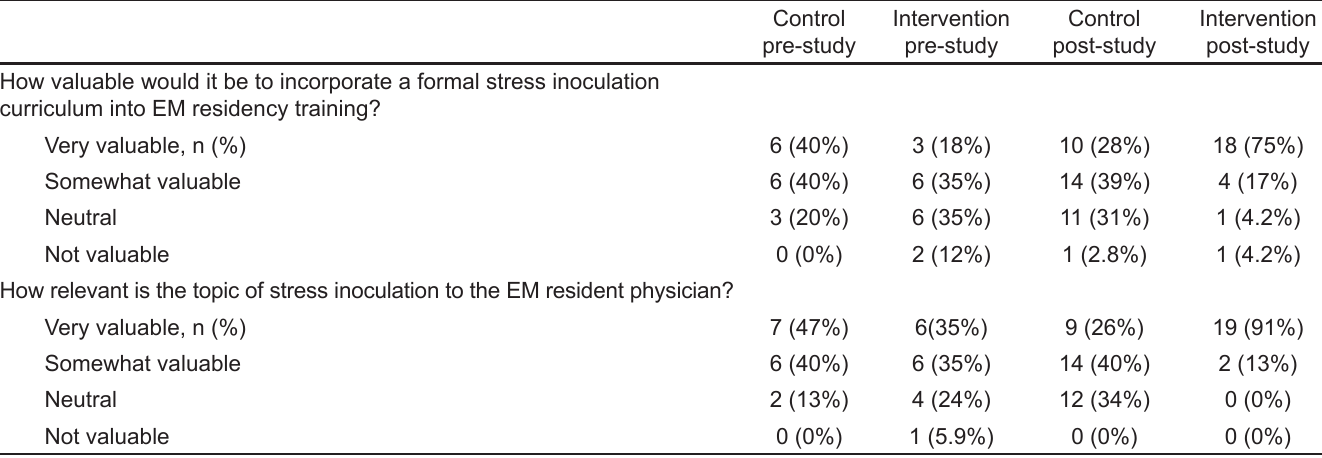
Table 4. Comparisons of pre- and post-intervention survey responses*.